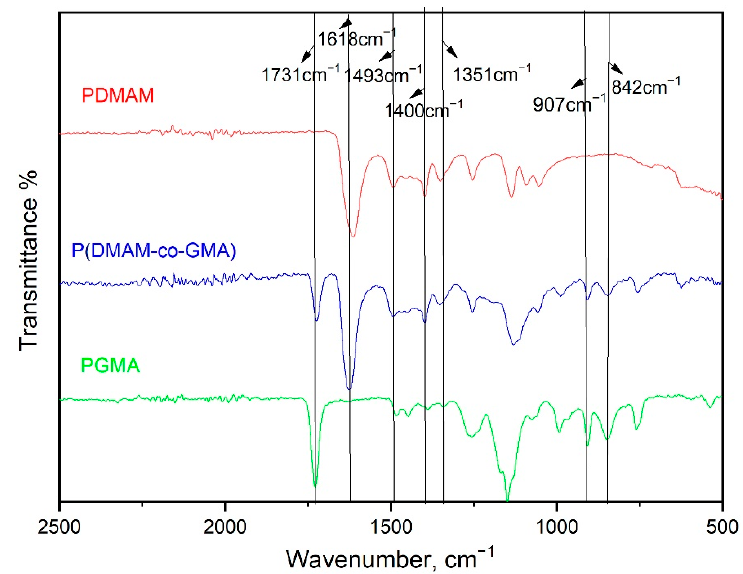
Figure 3. ATR-FTIR spectrum in the 500–2500 cm − 1 region of the copolymer P(DMAM-co-GMA) in comparison with the spectra of the homopolymers PDMAM and PGMA.